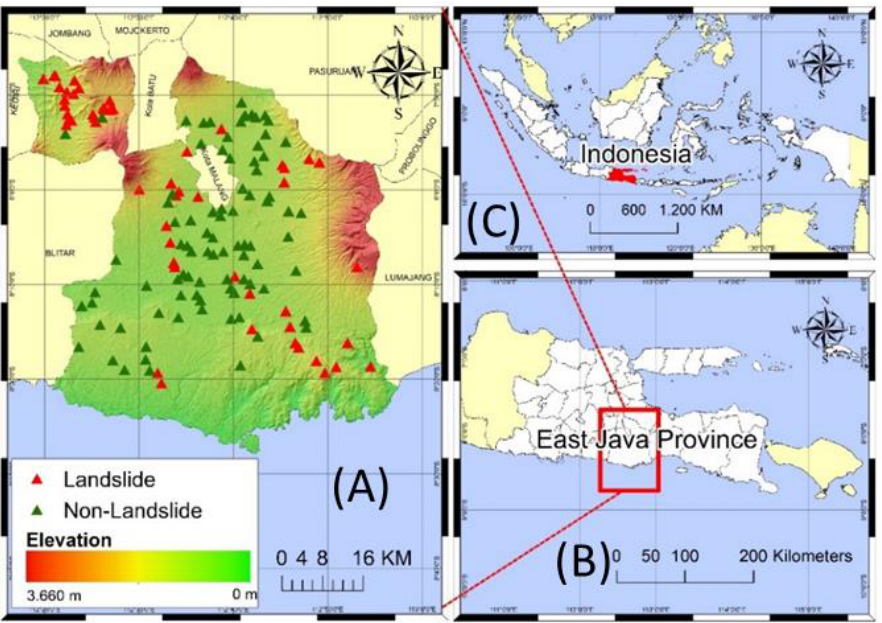
Figure 1. Location of the study area. ( A ) Elevation of the study area and distribution of training points. ( B ) The location of the study area in East Java Province. ( C ) The location of East Java Province in Indonesia.